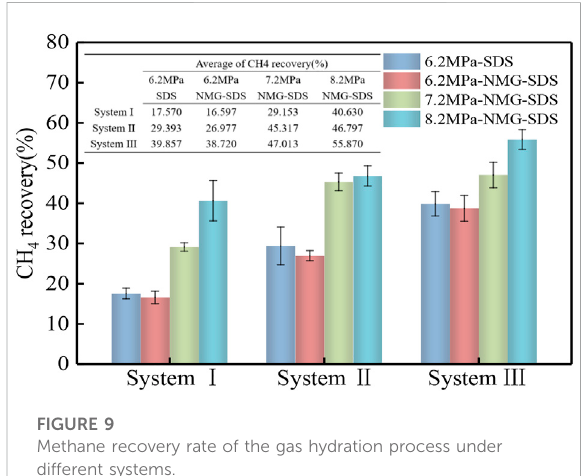
FIGURE 9 Methane recovery rate of the gas hydration process under different systems.